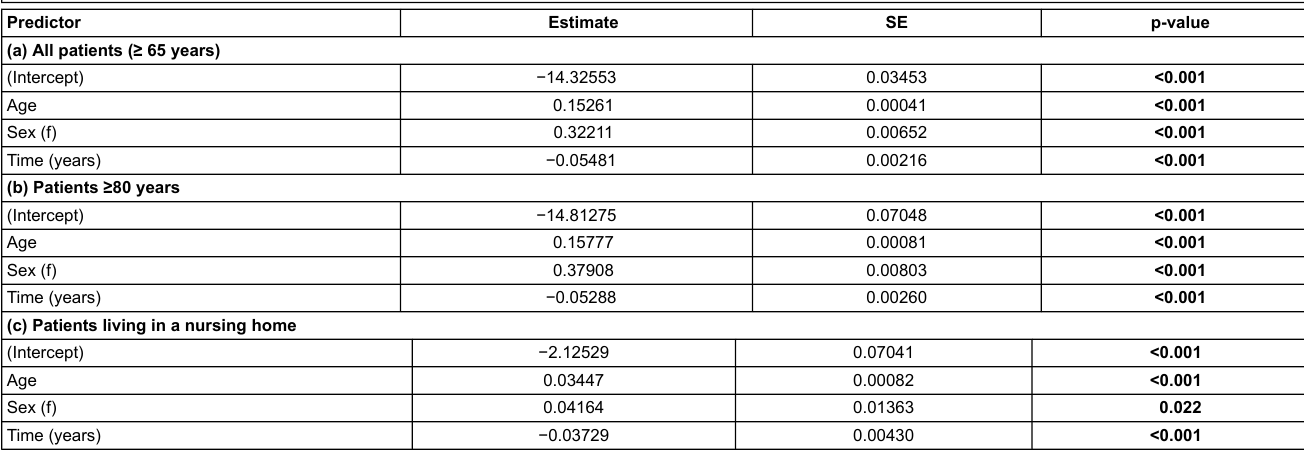
Table S2: The weighted total numbers of patients per year and the weighted number of patients with at least one GP home visit per year for (a) overall patients in the Swiss pop- ulation (extrapolated) (aged ≥65 years); (b) subgroup of patients ≥80 years; (c) subgroup of patients living in a nursing home in the same year. A significant decrease in GP home visit rates was observed in all patient groups (p <0.0001, controlled for age and sex) (table S1).